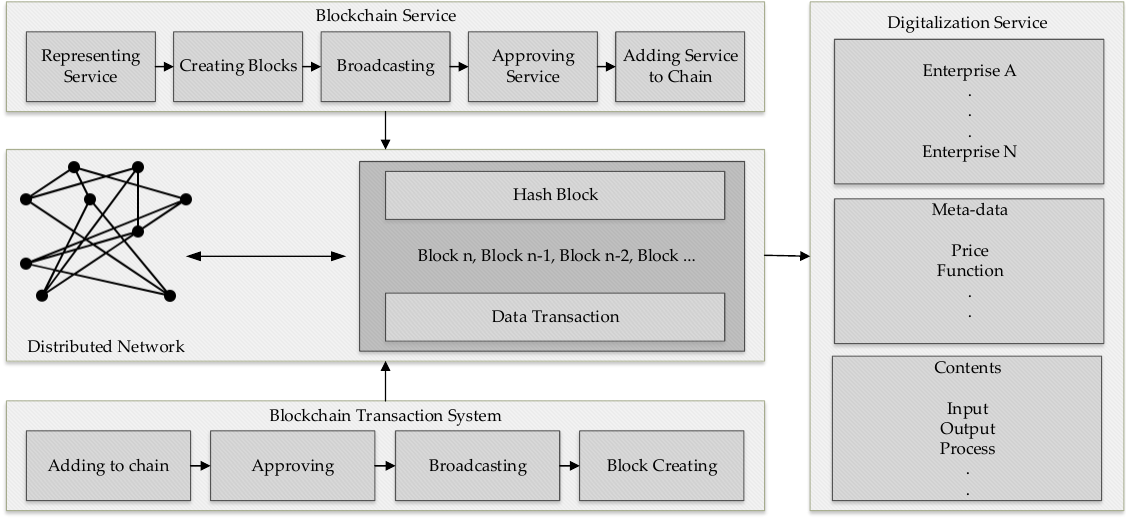
Figure 3. Overview of a blockchain